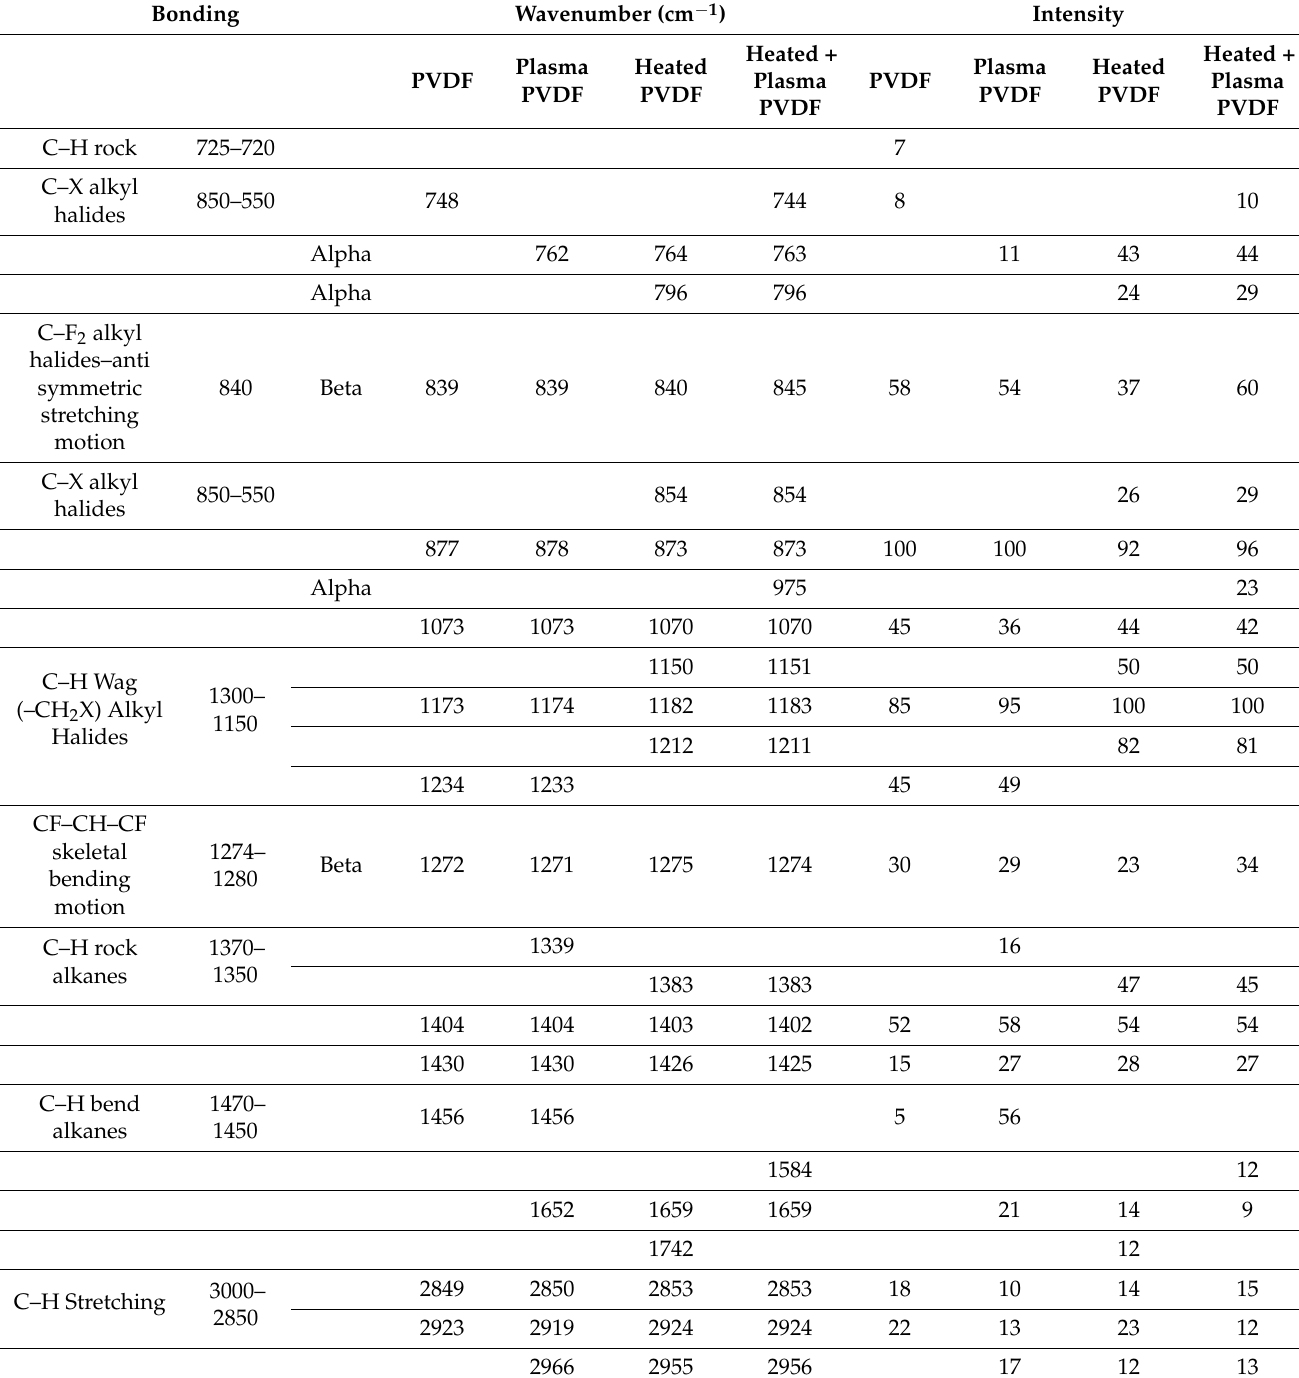
Table 3. FTIR wave number of an electro spun PVDF